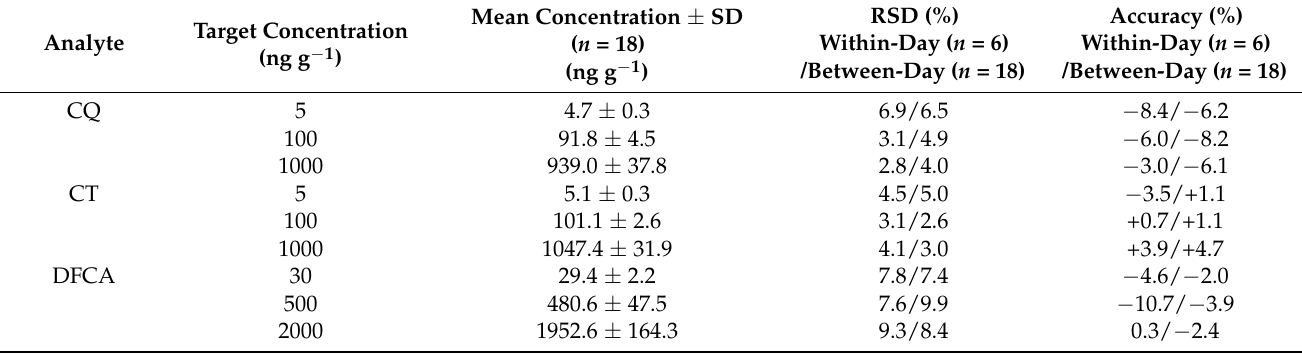
Table 3. The within-day ( n = 6) and between-day ( n = 18) precision and accuracy data for cefquinome (CQ), ceftiofur (CT) and desfuroylceftiofuracetamide